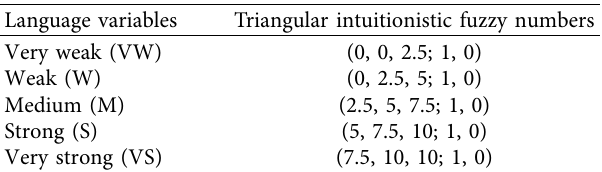
Table 2: Language variables and corresponding triangular intui- tionistic fuzzy numbers. Language variables Triangular intuitionistic fuzzy